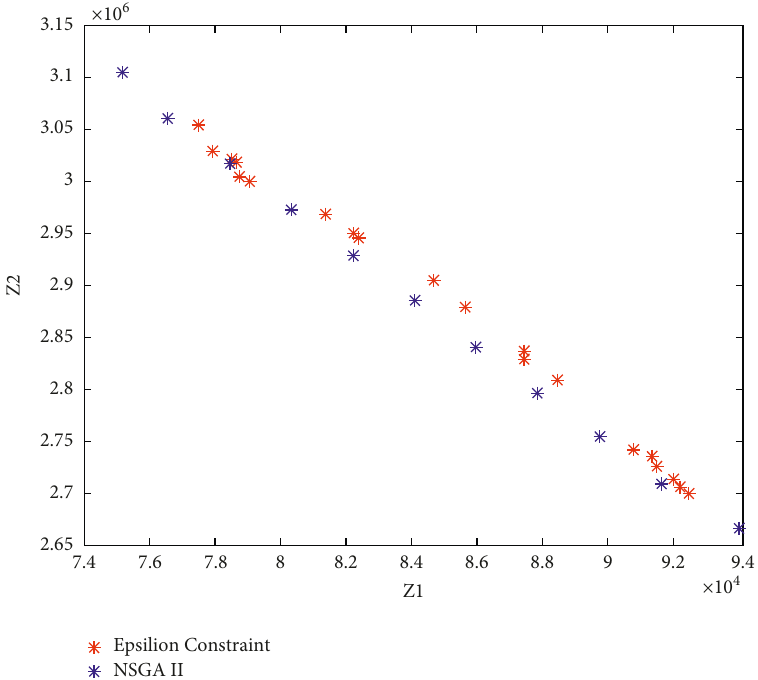
Figure 5: Pareto front obtained from solving the mathematical model of sustainable